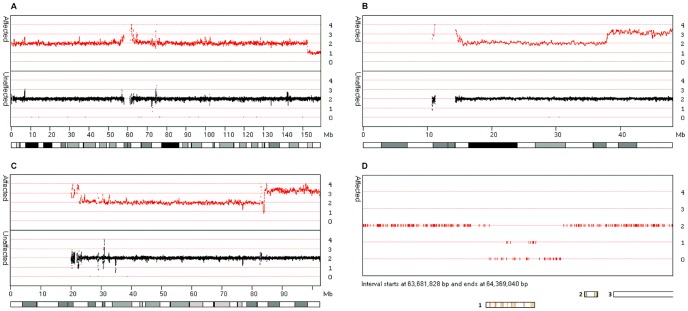
Identification of CNVs in patients 1, 2 and 3.
Figures 2A to 2C show comparison of data from Patients One and Two, compared to data from 8 individuals unrelated to the patients. Figures 2A and 2B display ‘Smooth signal’ data for chromosomes 7 and 21, respectively, for Patient One and identify the location of a 7 Mb (152.1 to 159.0 Mb) deletion and a 10.2 Mb (36.8 to 47.0 MB) duplication. Figure 2C displays the ‘Smooth signal’ data for chromosome 15 of Patient Two and shows an 18.5 Mb (81.8 to 100.3 Mb) duplication. Figure 2D displays the ‘CN state’ data, from Patient Three, for an interval on chromosome 12 starting at 63.68 Mb and ending at 64.37 Mb. This clearly shows the presence of a 160 Kb homozygous deletion, which encompasses the DPY10L2 gene locus (labelled 1), while not affecting the nearby TMEM5 and SRGAP1 (labelled 2 and 3, respectively) genes.